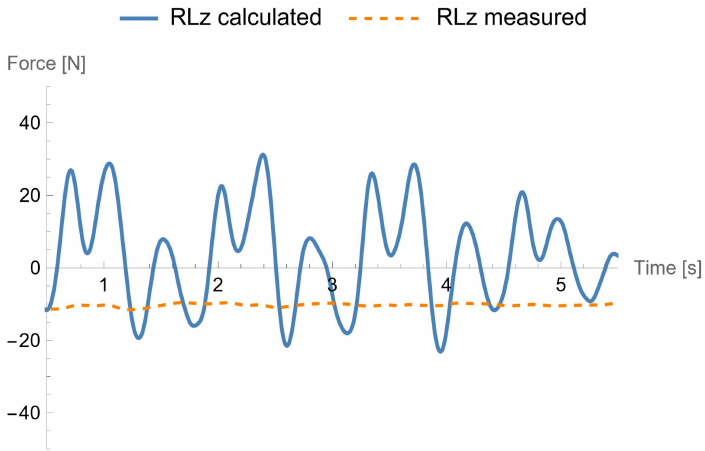
Figure 9. The horizontal component, RL z , of the GRF for the left foot in the case of the exercises with upper limbs swinging. The RL z measured with the dynamometric plate is drawn using the dashed line, and the RL z calculated is drawn using the solid